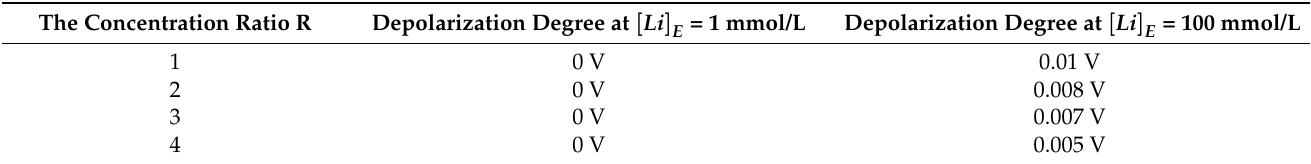
Table 21. The table shows the depolarization degree based on the classical transport of both isotopes as in graph (b) of Figure